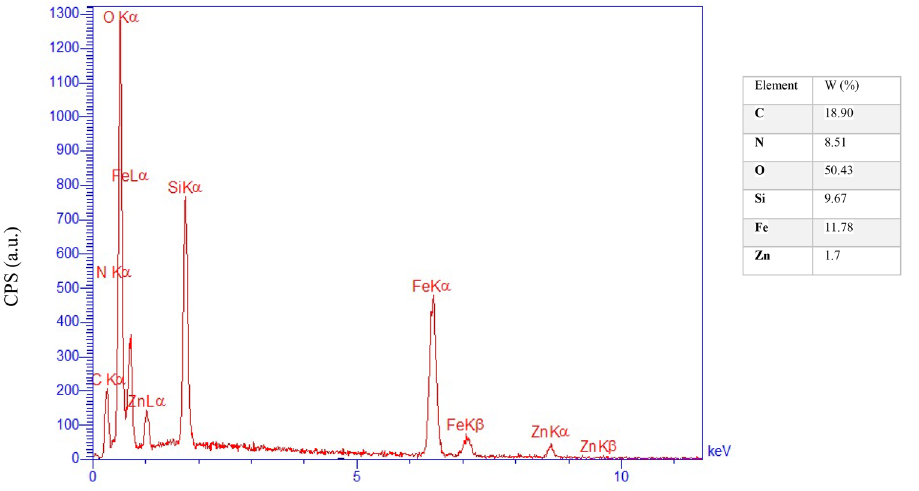
Figure 4. EDX spectrum of the magnetic Fe 3 O 4 @PMO-ICS-ZnO mesoporous catalyst ( 1